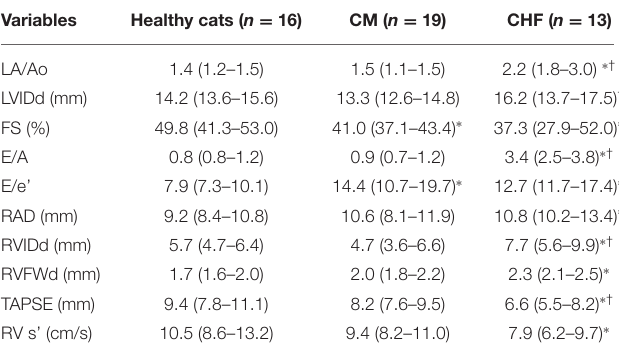
TABLE 2 | Results of conventional echocardiographic indices in cats with cardiomyopathy and healthy controls. Variables